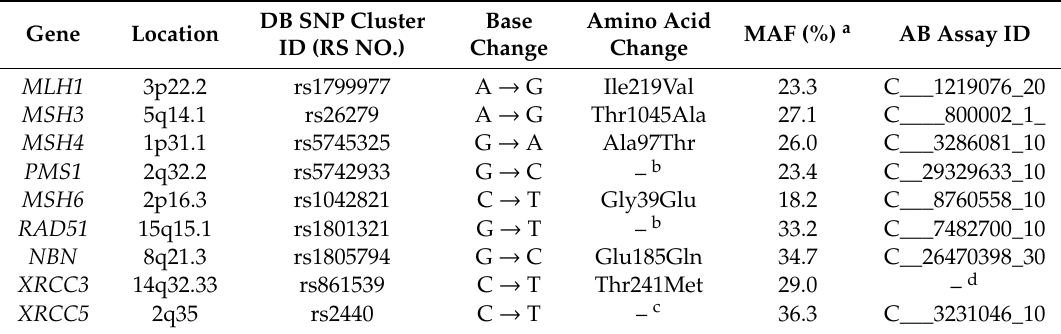
Table 1. Selected SNPs and detailed information on the corresponding base and amino acid changes, minor allele frequency, and Applied Biosystems (AB) assay used for